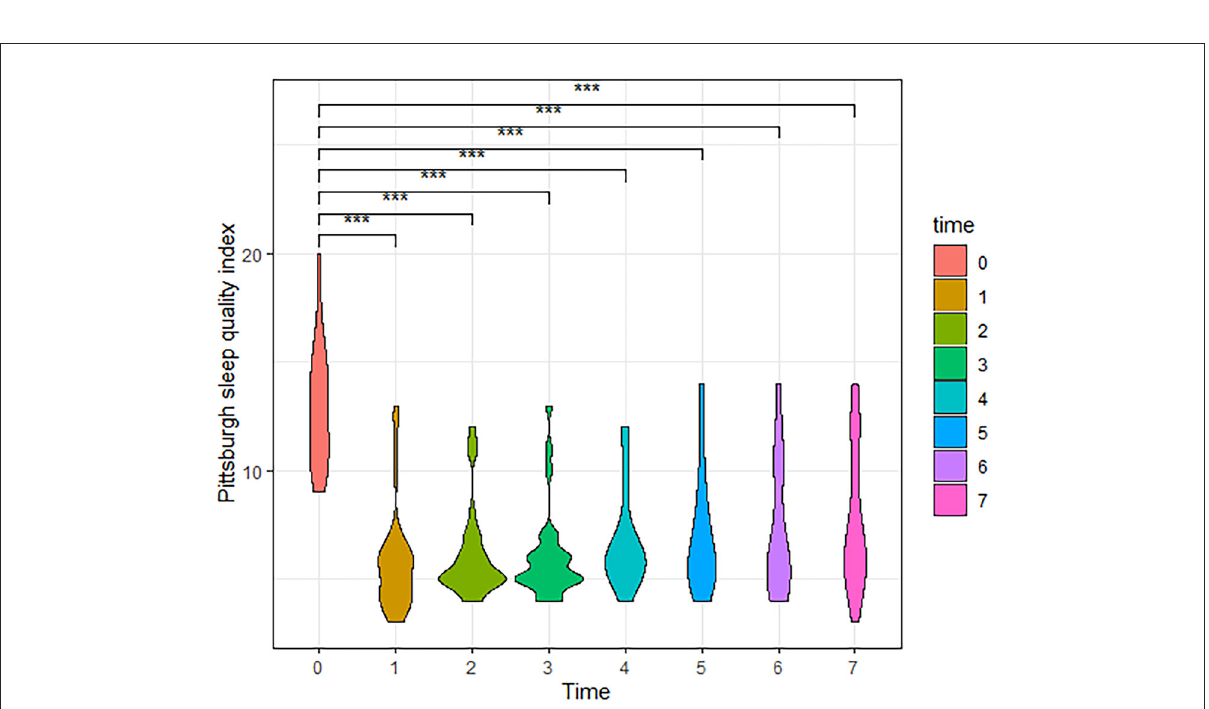
FIGURE5 The Violin Plot of Pittsburgh Sleep Quality Index (PSQI) scores based on 28 patients followed up to 3 years postoperatively. Compared with the preoperative, patients had significantly lower PSQI scores at all postoperative time periods. (t0, Pre-operation; t1, Post-operation; t2, One month; t3, Three months; t4, Six months; t5, One year; t6, Two years; t7, Three years, *** P <